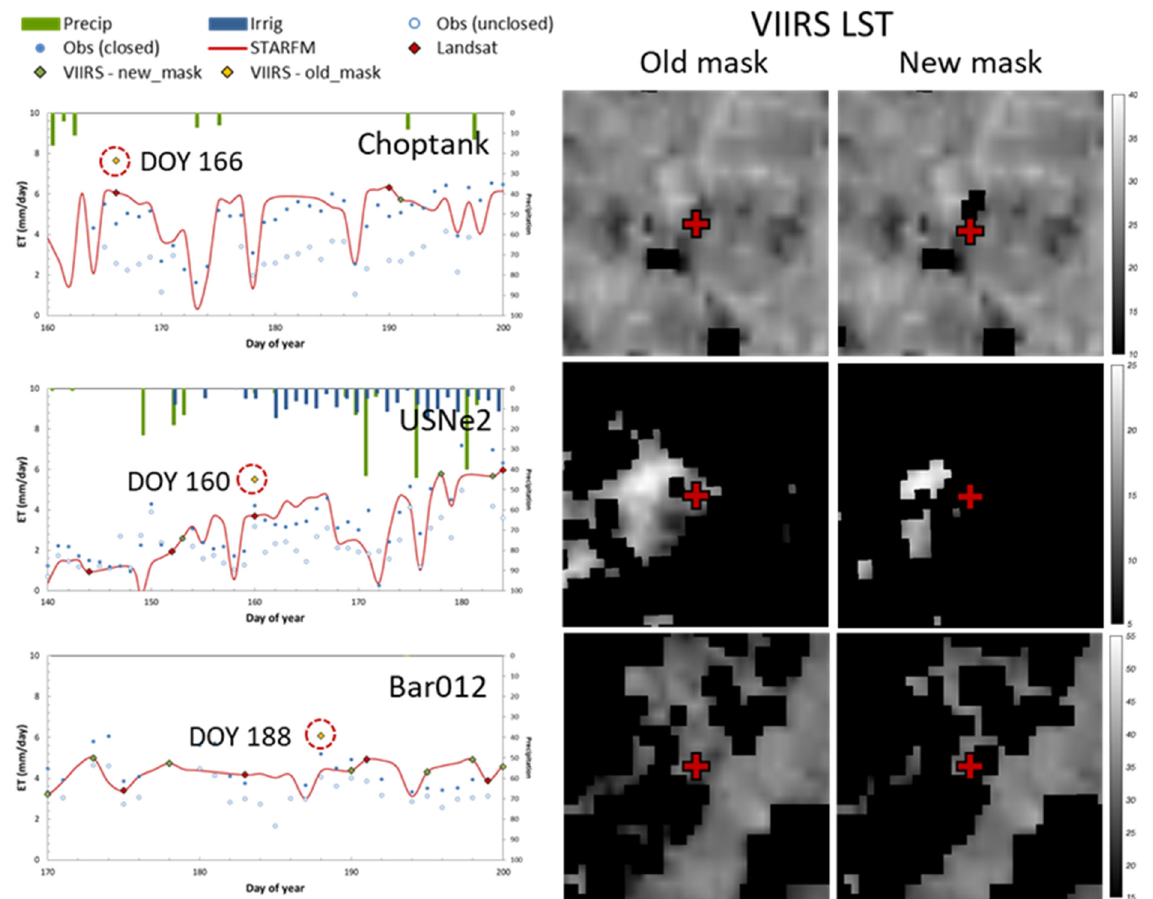
Figure 15. Comparison of ET retrievals at the Choptank, USNe2 and Bar012 sites ( first column ). VIIRS ET with cloud cover near the tower not successfully flagged by the old cloud mask is highlighted in red circle. Comparison between VIIRS LST maps (400 × 400) with old ( second column ) and new ( third column ) cloud mask, centered on each flux tower site. The black pixel indicates cloud cover detected by the mask, and the red cross represents the location of flux tower. Note that DOY 166 at Choptank site and DOY 160 at USNe2 site are the two points highlighted in Figure 5.